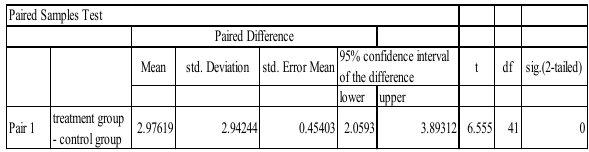
Figure 1: Comparing the effect of moist dressing in treatment group and oil gauze dressing in control group on the wound healing time.